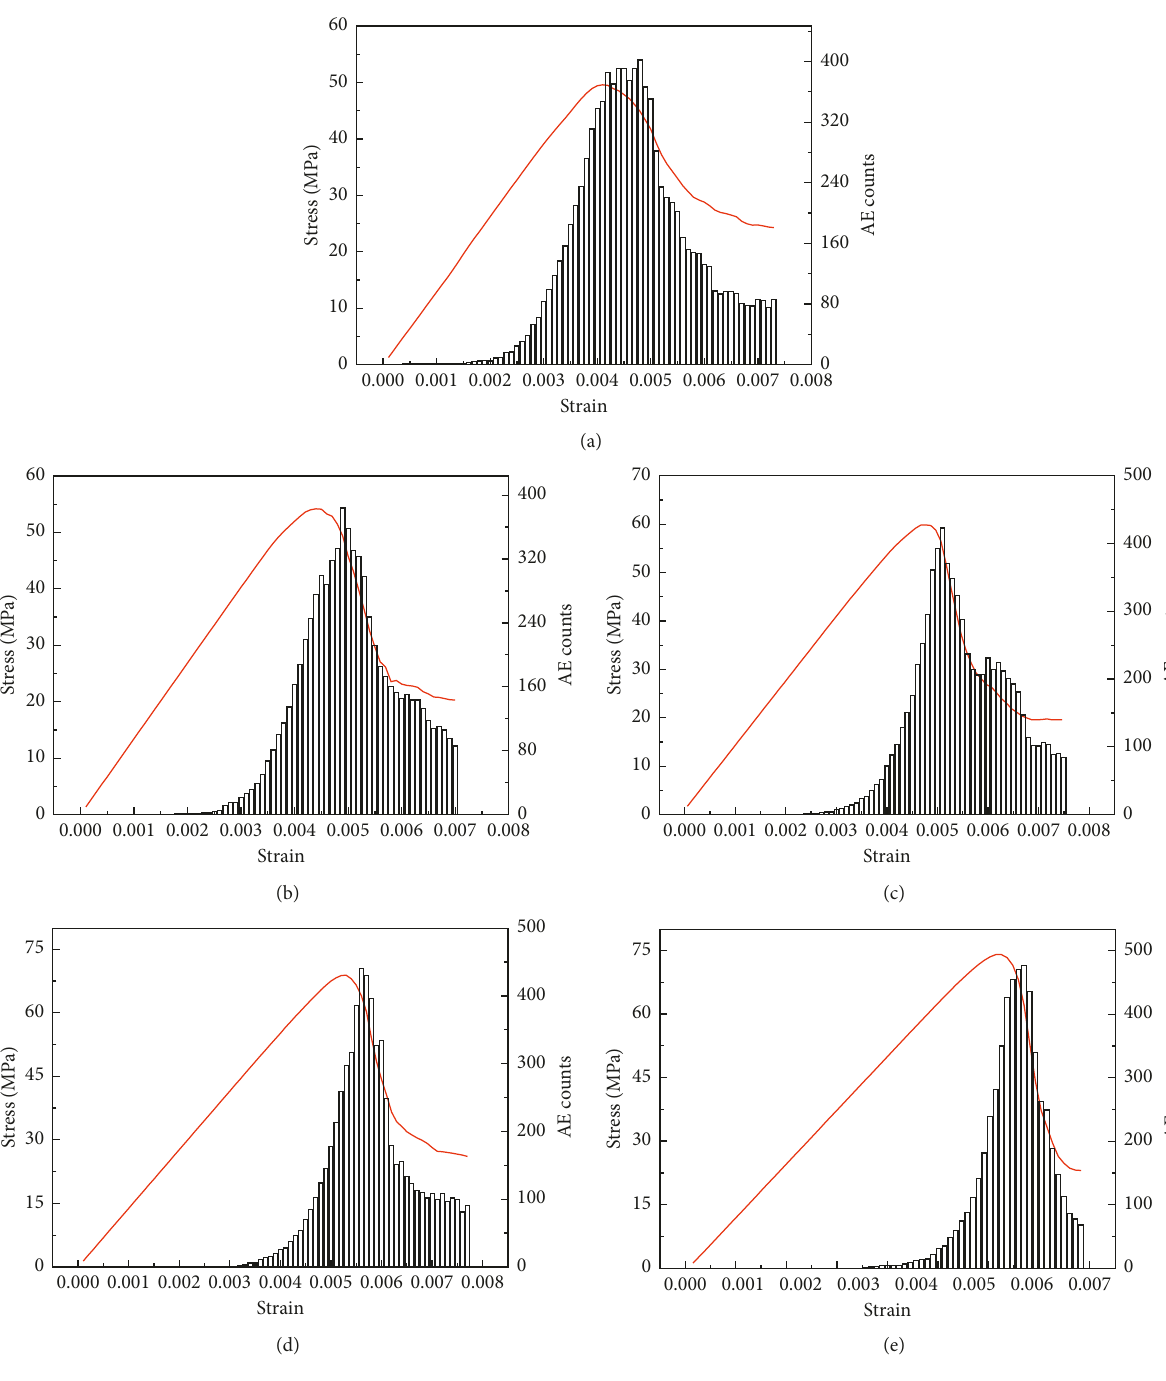
Figure 7: The stress-strain curve and acoustic emission of uniaxial compressive tests of various homogeneity indexes ( λ ). (a) λ (c) λ 5; (d) λ 6; (e) λ (cid:30) (cid:30) (cid:30)